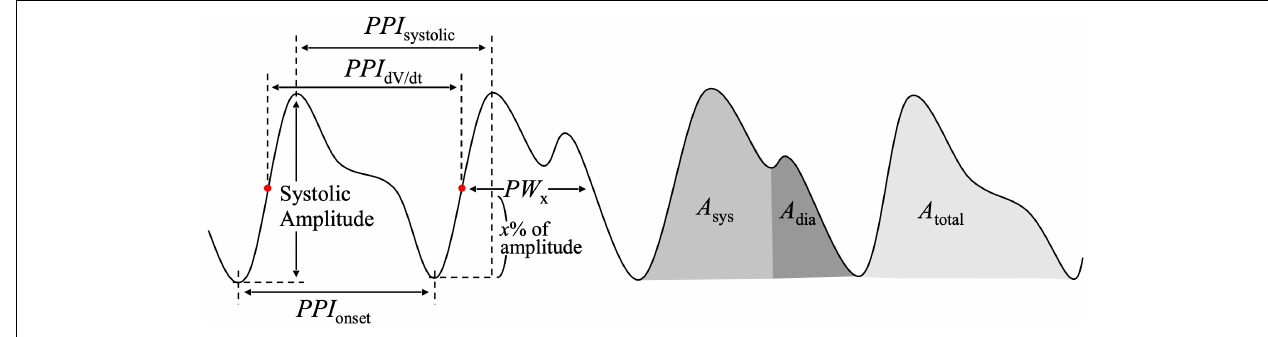
FIGURE 4 | Features of the photoplethysmogram waveform. PPI systolic , interval between systolic peaks of adjacent pulse; PPI dV / dt , interval between maximum dV/dt of adjacent pulse; PPI onset , interval between pulse onsets of adjacent pulse; PW x , pulse width at x % of systolic amplitude; A sys , systolic area; A dia , diastolic area; A total , total pulse